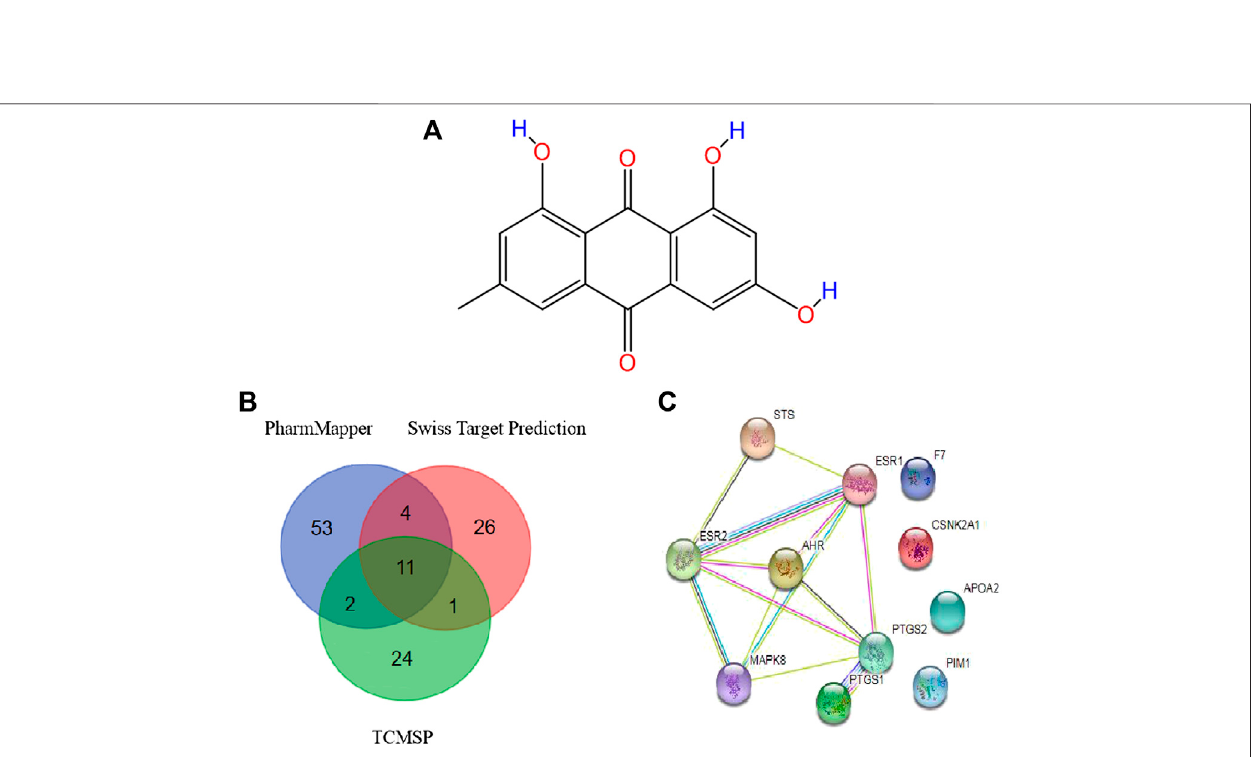
Frontiers in Pharmacology |